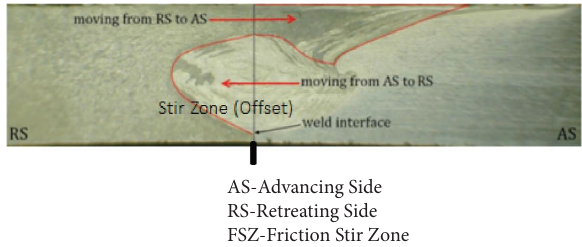
Figure 5: Weld cross section of the AA 5154-AA6063 dissimilar joint at the AS and RS side showing the FSZ.